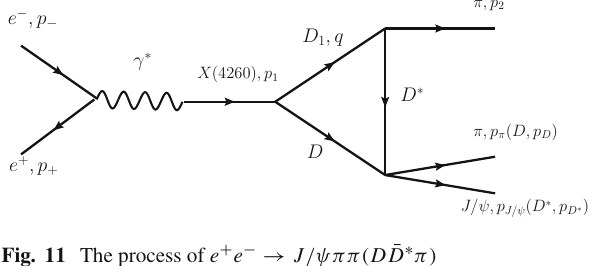
1 + γ − ln ( 4 π) − 1 E (cid:4)